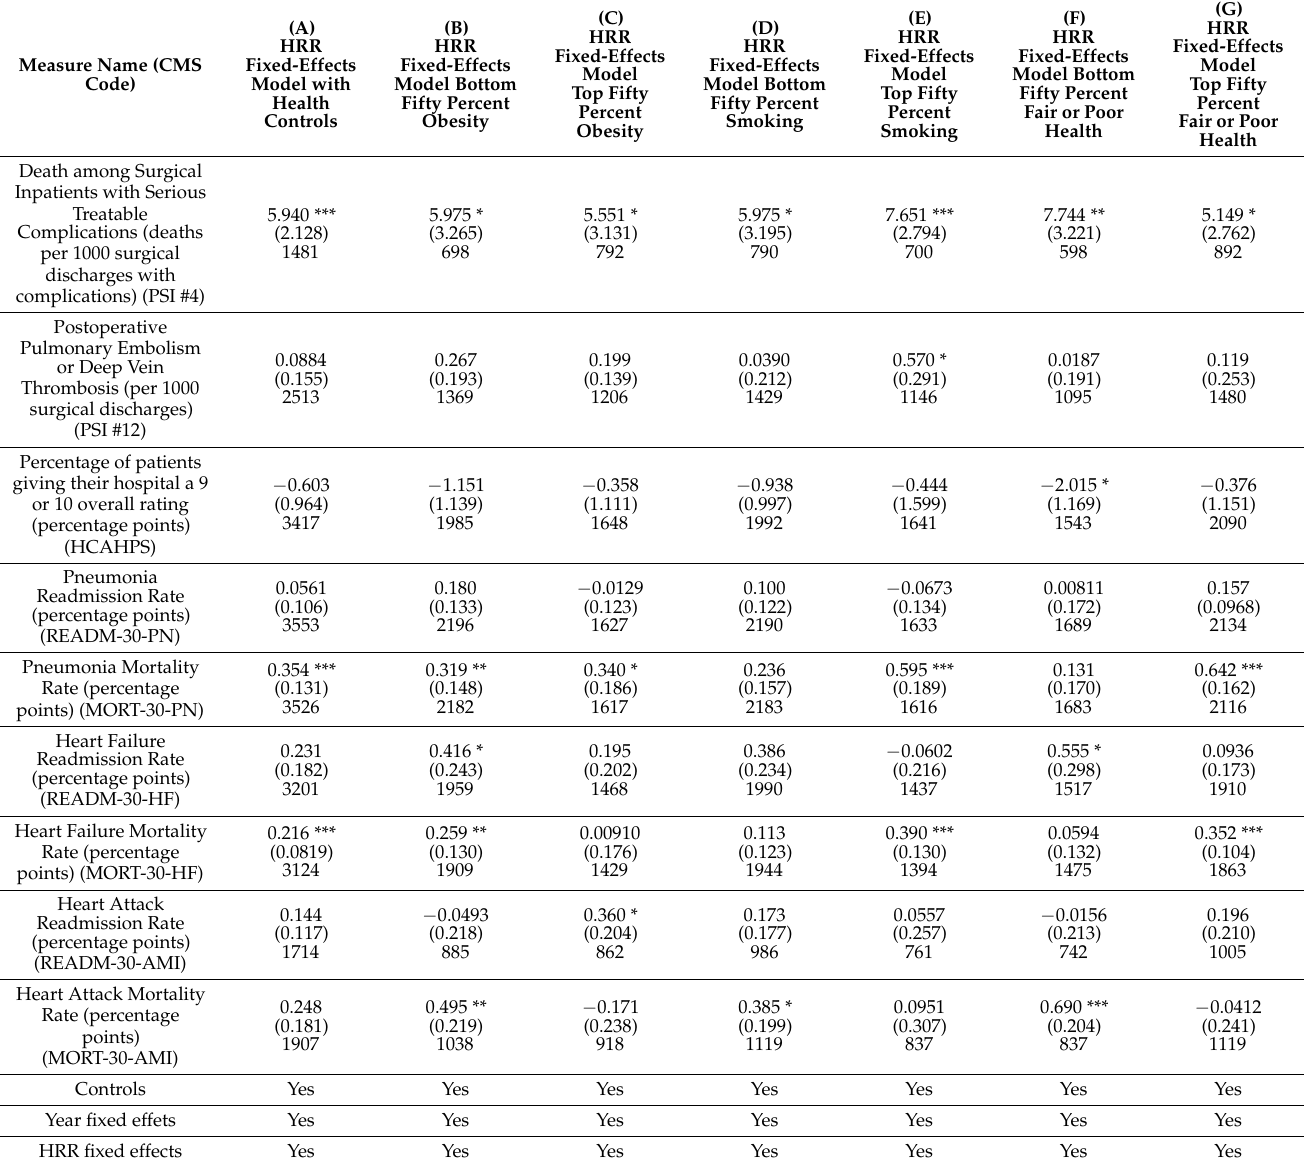
Table 8. Pooled regression results